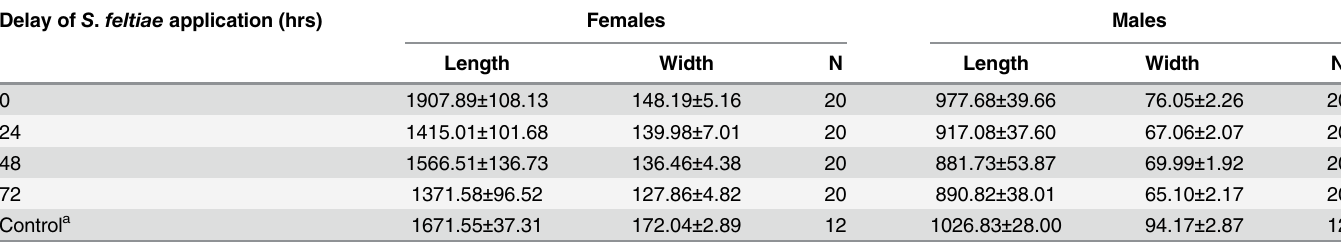
Table 7. Mean body length and body width ( μ m ± SE) of S . feltia e adults recovered from cadavers of L . decemlineata last-instar larvae infected by I . fumosorosea CCM 8367 and inoculated with 500 IJs per dish in different times after the fungus application. Delay of S . feltiae application